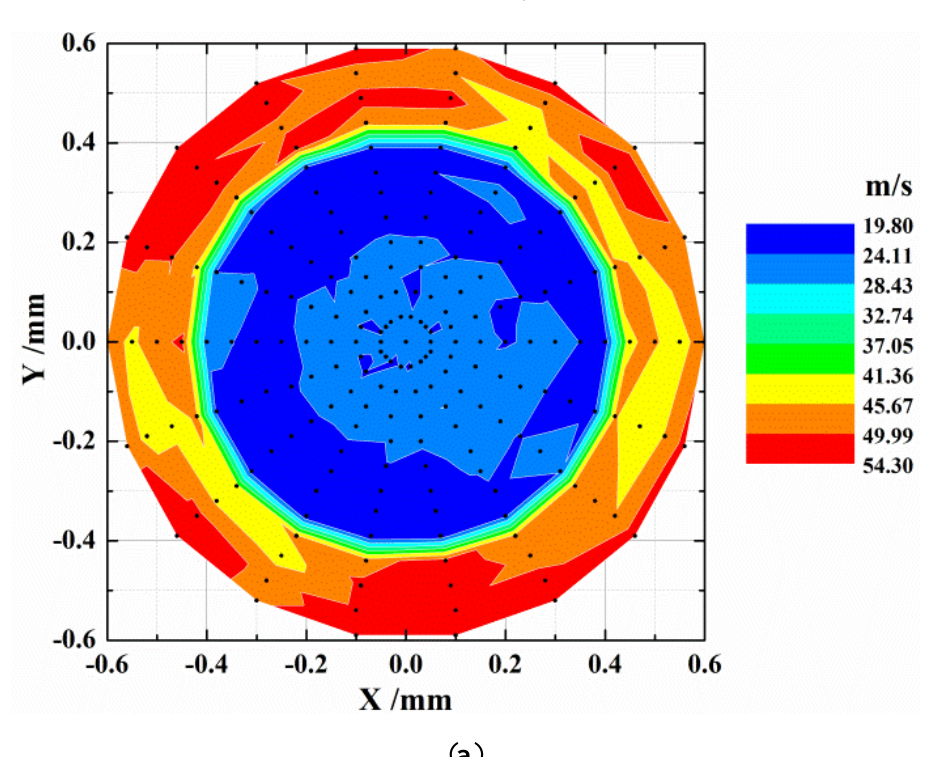
Figure 5. Distributions of root-mean-square velocity at ( a ) Z = 3.0 mm; and ( b ) Z = 7.0